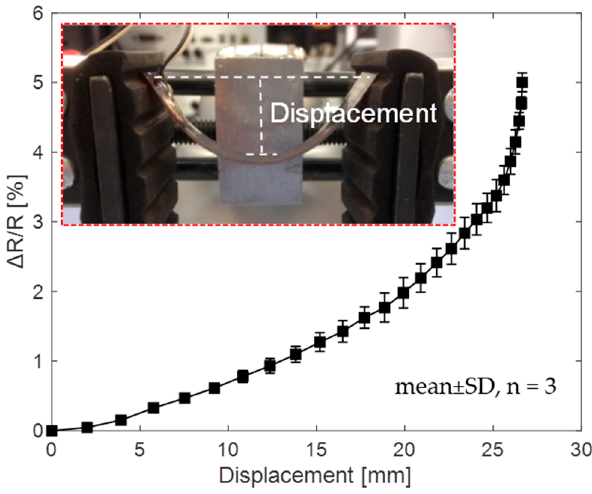
Figure 5. Resistance response to various displacement values when the sensor is bent.